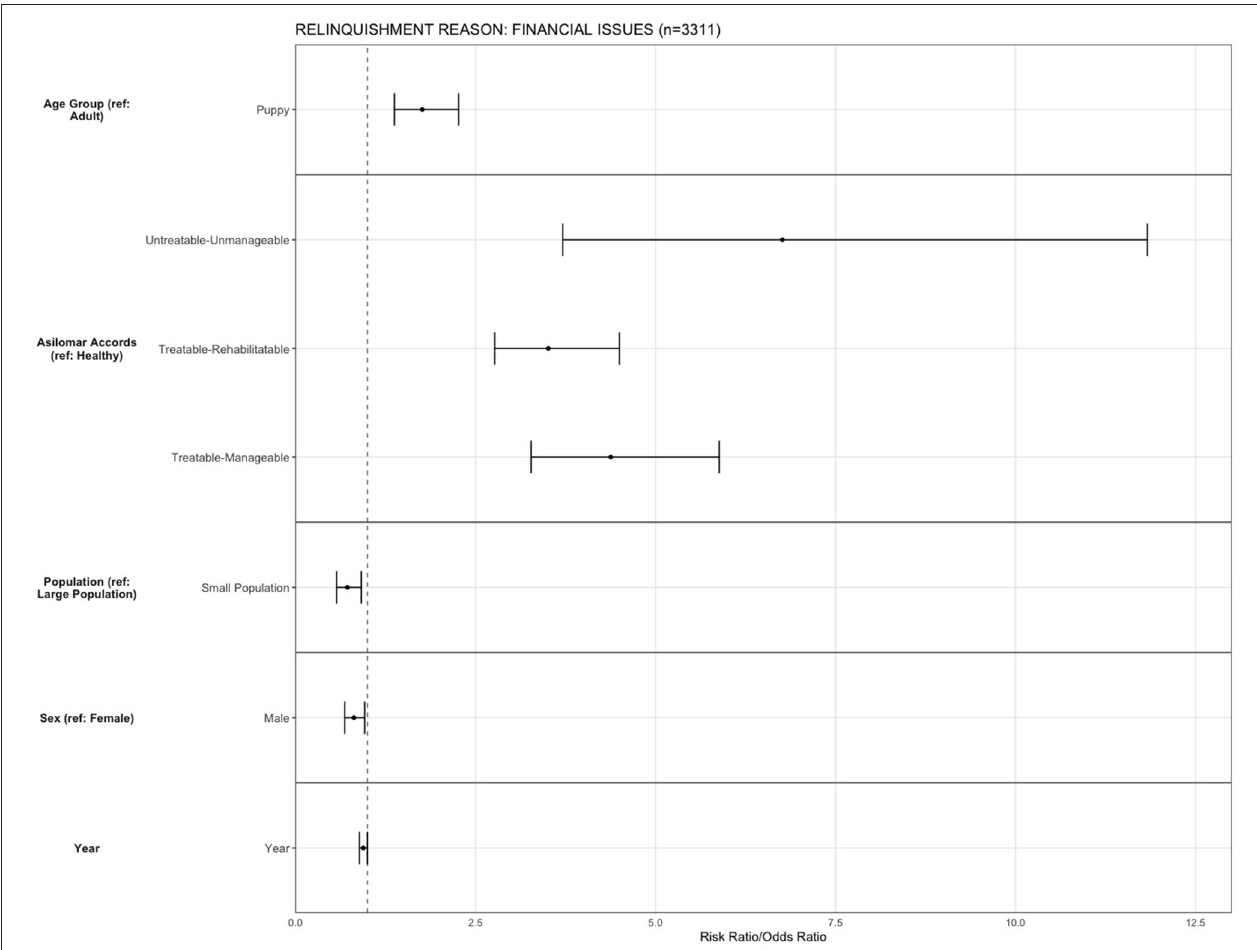
FIGURE 7 | The association between relinquishment reason and animal characteristics for puppies and dogs relinquished for the reason of “financial issues” ( n = 3,311). Characteristics include age group, Asilomar Accords category, breed type, dog size, sex, population center size, and year. The results of the logistic regression model are shown. Data are presented by risk ratios and their 95% confidence interval (bars); p < 0.05 when 95% confidence interval does not cross the vertical dotted line. A risk ratio > 1 suggests an increased risk of relinquishment of that the characteristic category, while a risk ratio < 1 suggests a reduced risk. Non-statistically significant results are excluded from the